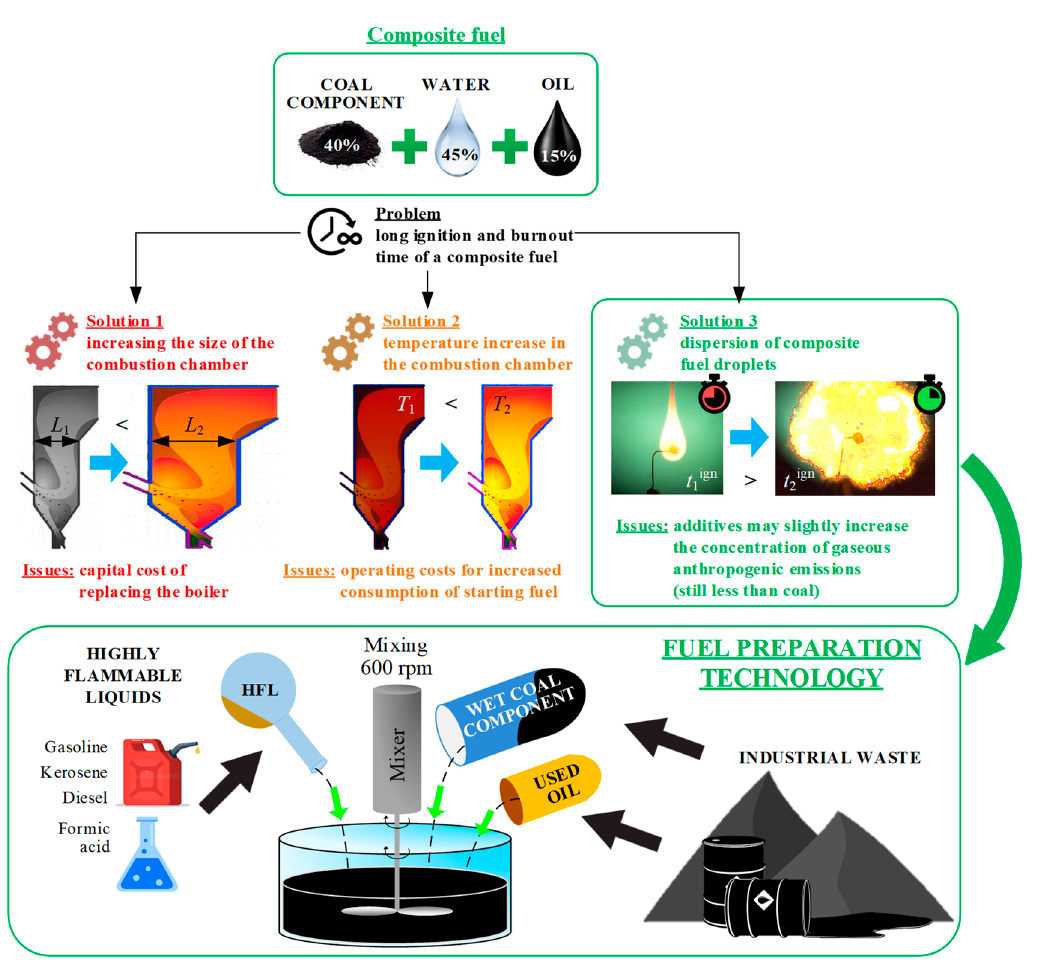
Figure 11. Practical solutions to the problem of long ignition delay times for composite fuels.